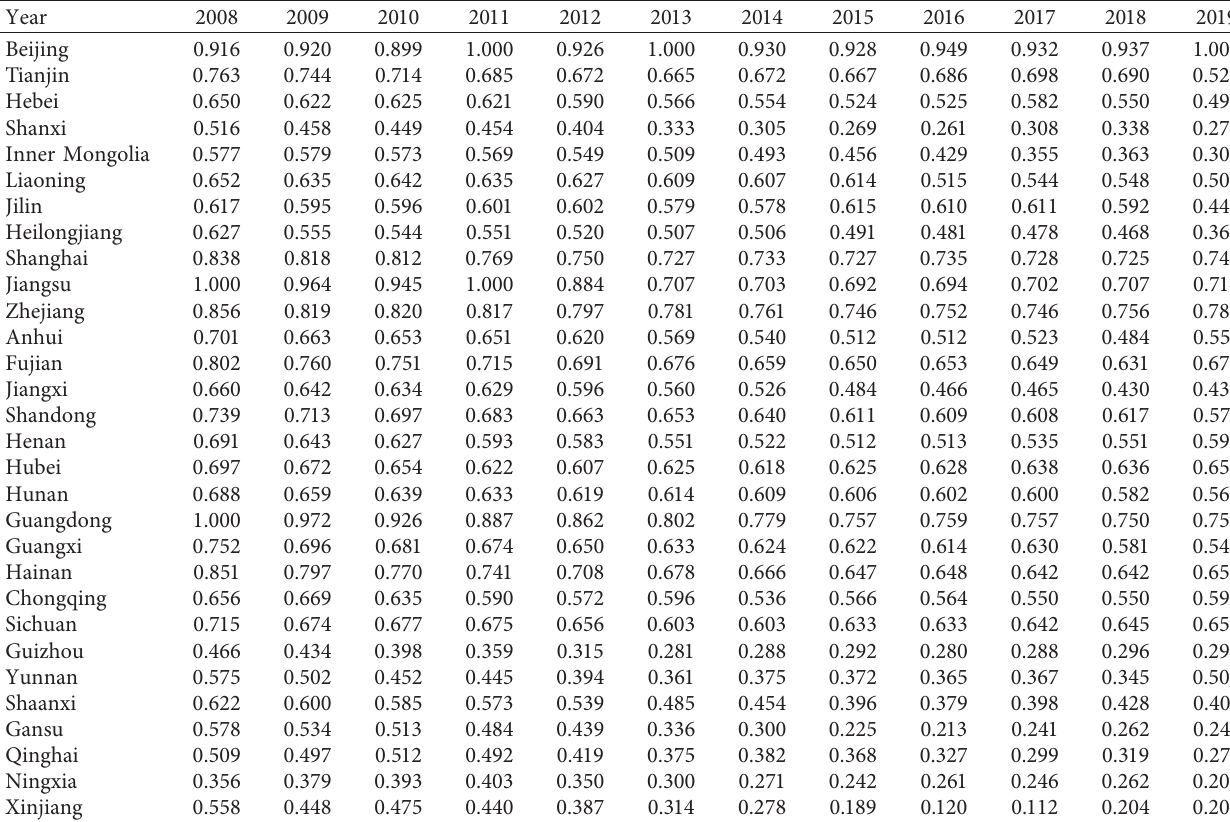
Table 6: Ecological efficiency scores of 30 provinces and cities in